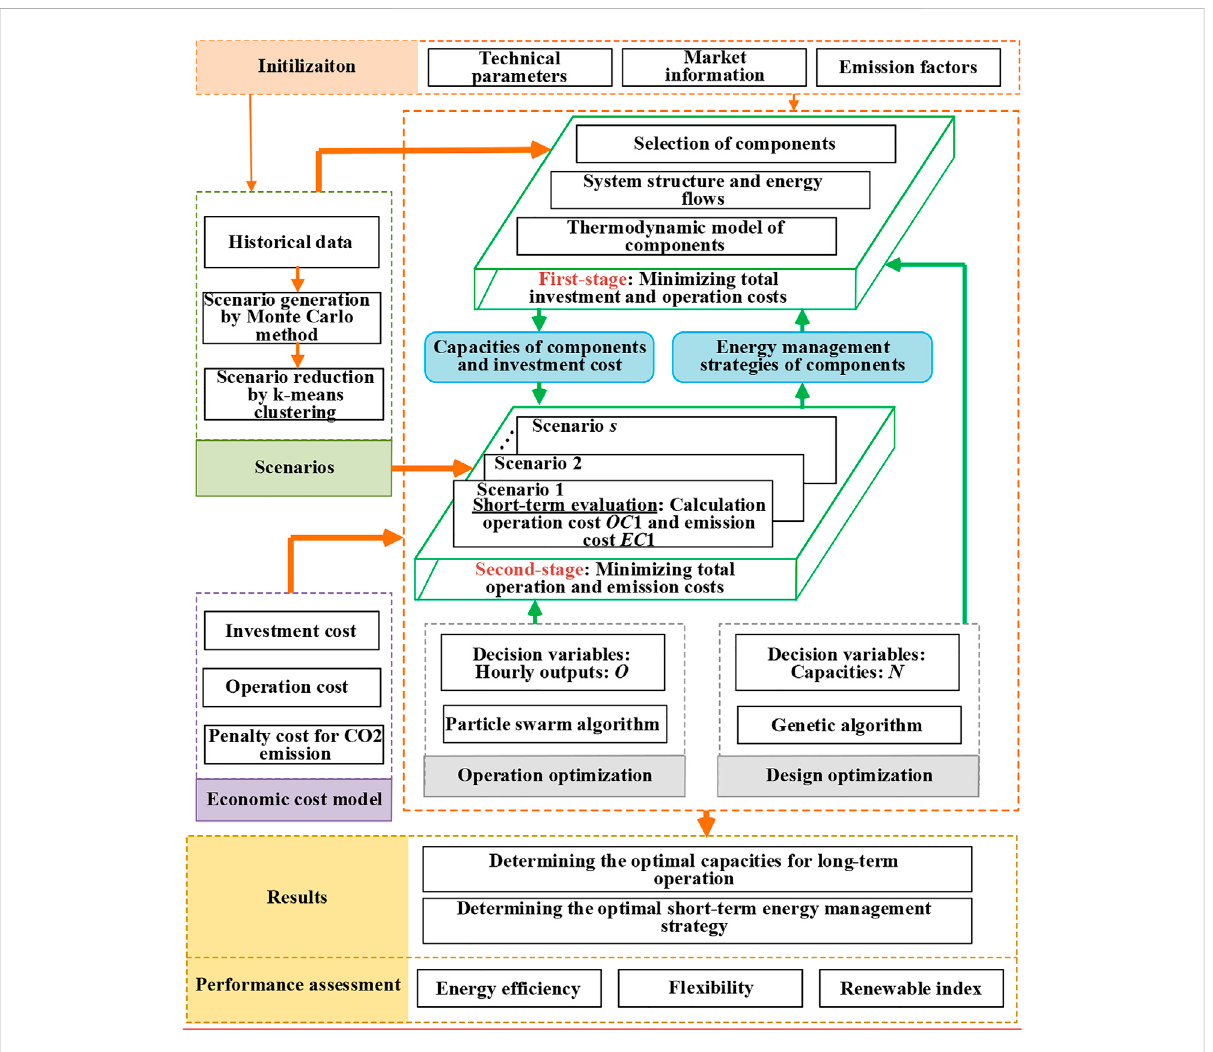
FIGURE 2 Framework of two-layer collaborative stochastic